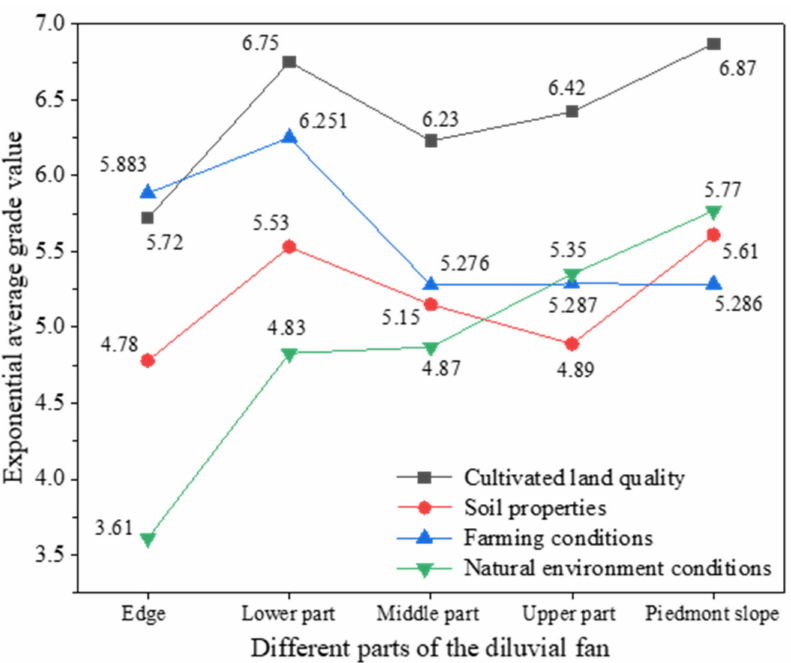
Figure 13. Cultivated land quality and three dimensions index grade changes at different parts of the diluvial